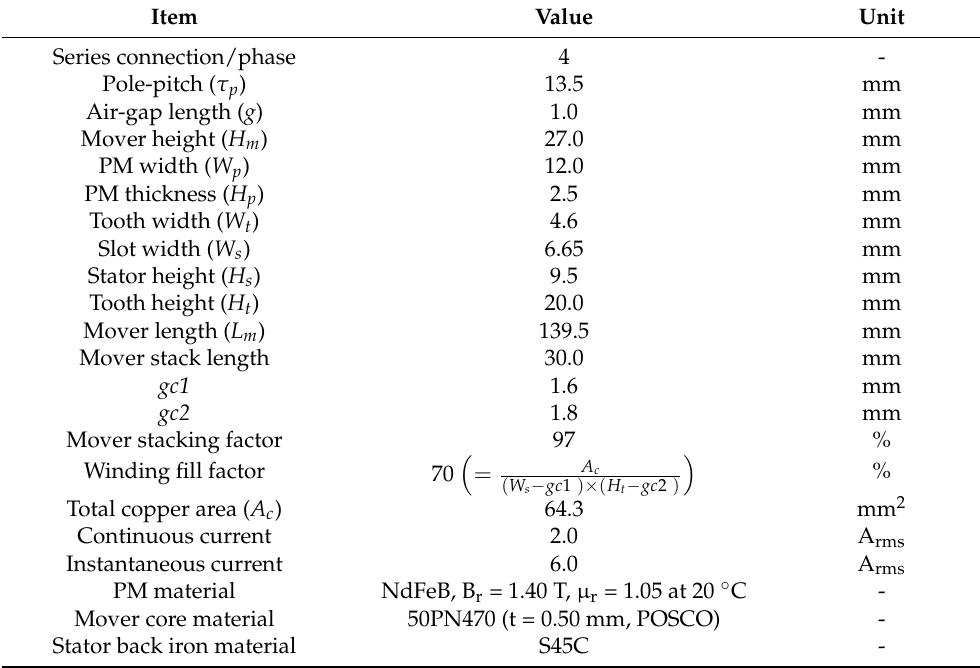
Table 5. Prototype geometry.